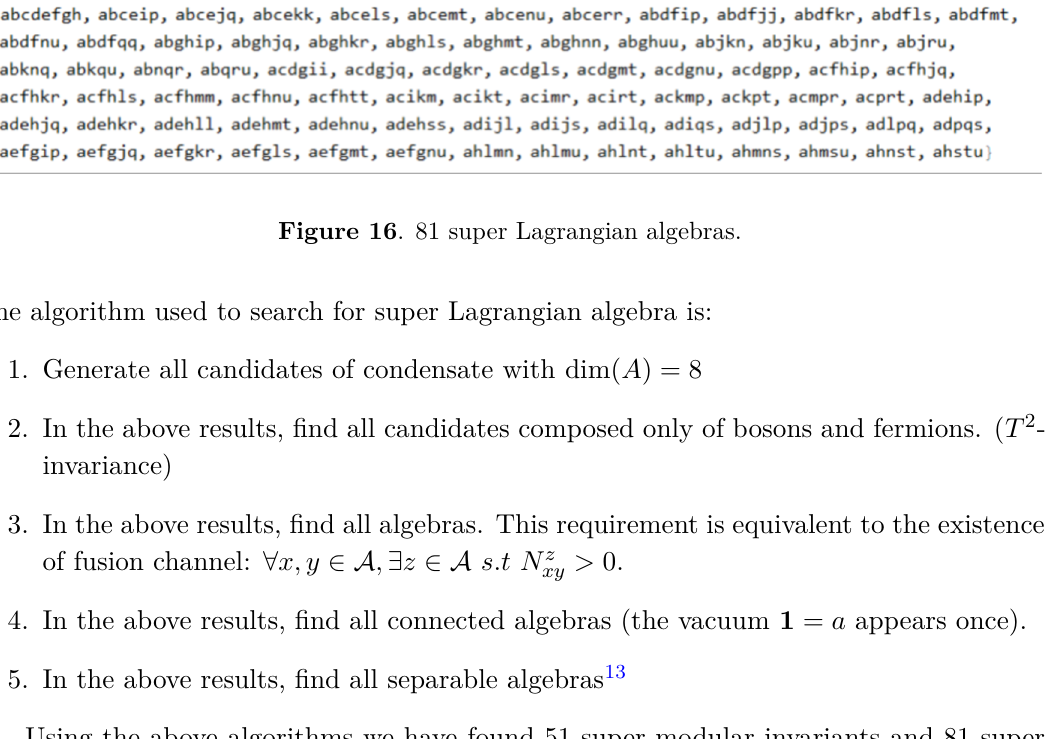
Figure 15 . 51 super modular invariants.